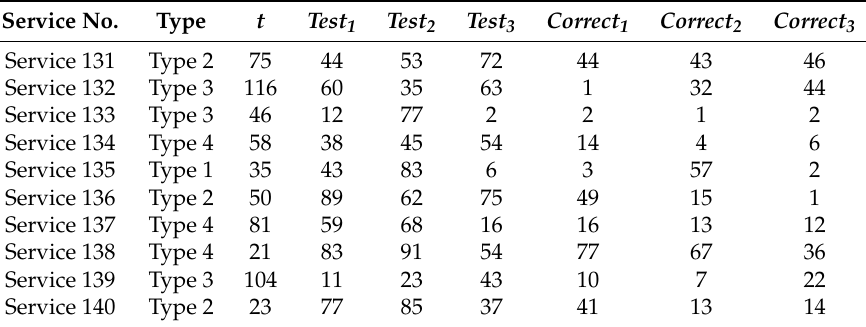
Table 4. Part of the test service set.